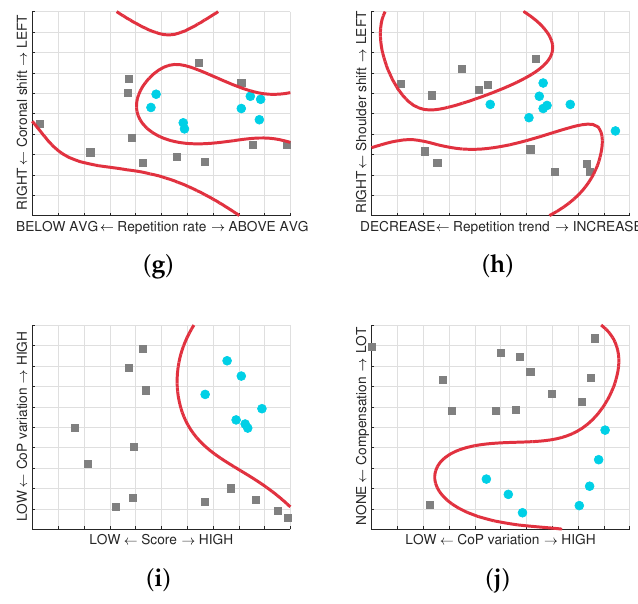
Figure 18. Training data with decision boundary for OwlNest ( a , b ); ShelfCans ( c , d ); FlappyCloud ( e , f ); EquilibriumPaint ( g , h ); and HotAir ( i , j ) serious